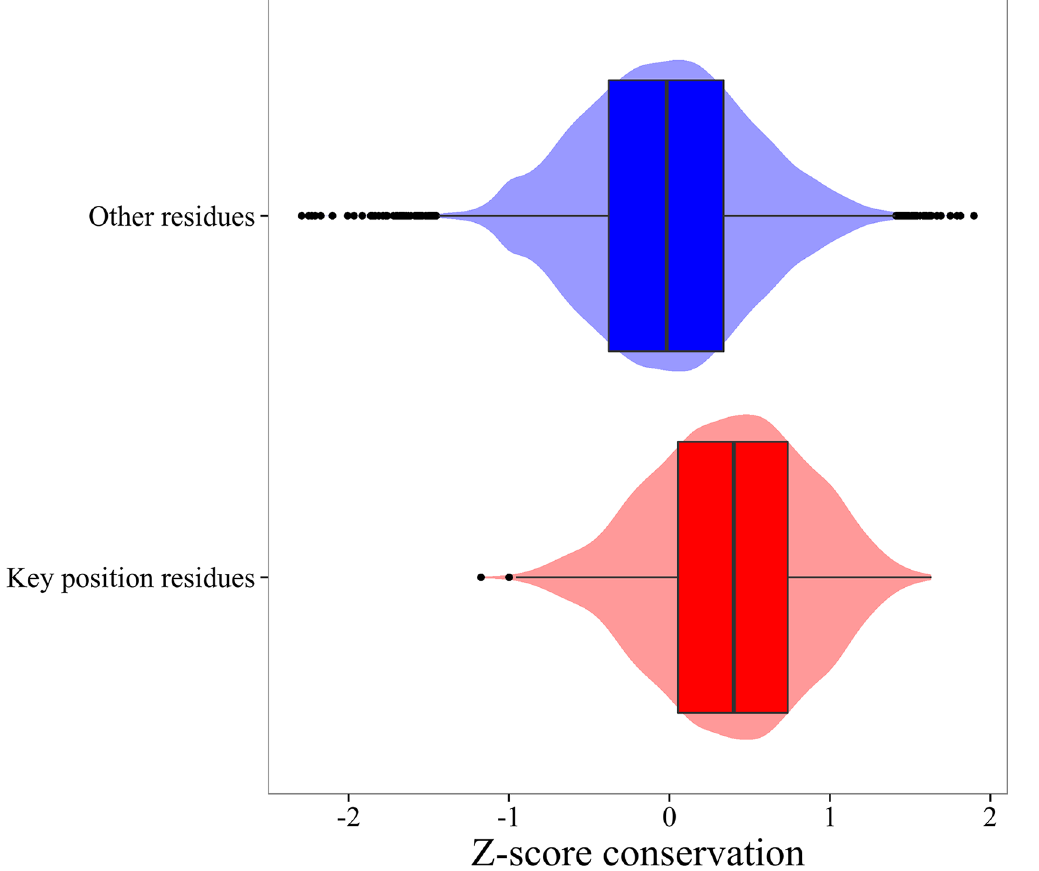
Fig 3. Distributions of the conservation measure Z evol ; i obtained for the selected key position residues (red), and all other residues (blue). The lower score and upper "hinges" of the box correspond to the fi rst and third quartile, and the black band inside the box is the median (Second quartile). The violin plot under the box plot shows the distribution of a given